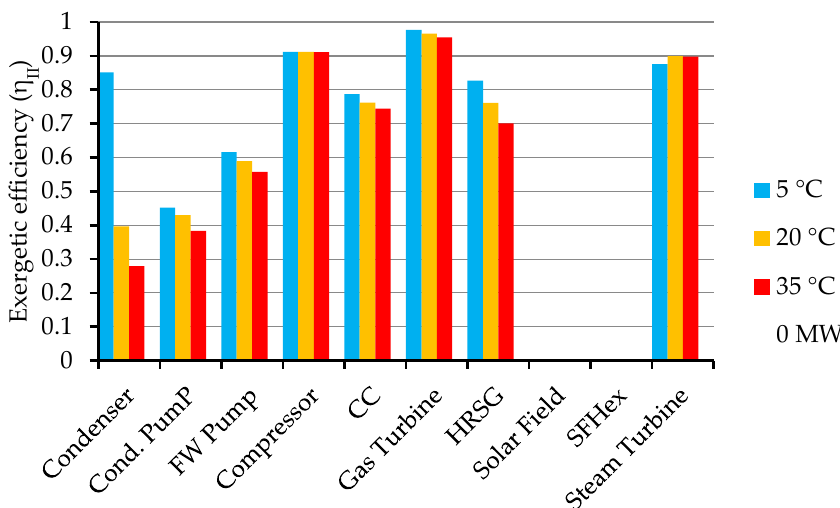
Figure 6. Exergetic efficiency of different components of the ISCC at different ambient temperatures for solar heat input equal to 0 MW.